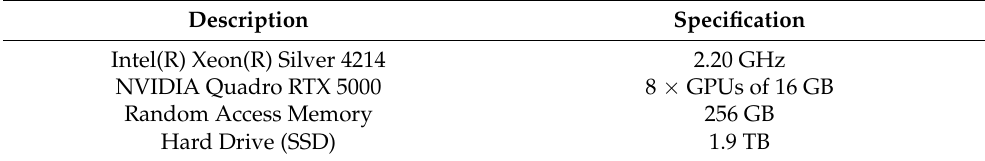
Table 1. Specifications of the used Deep Learning Server.